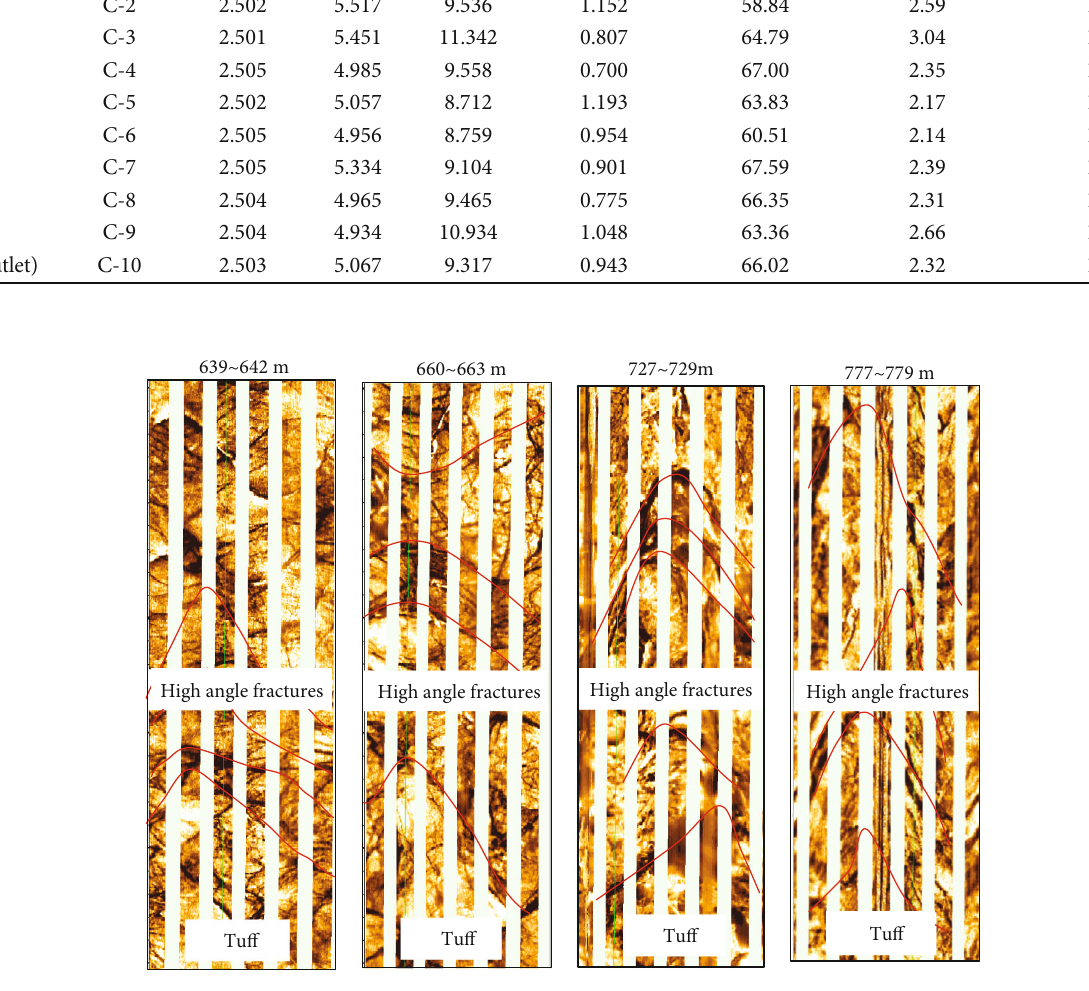
Figure 1: Description of imaging logging results in di ff erent well sections.